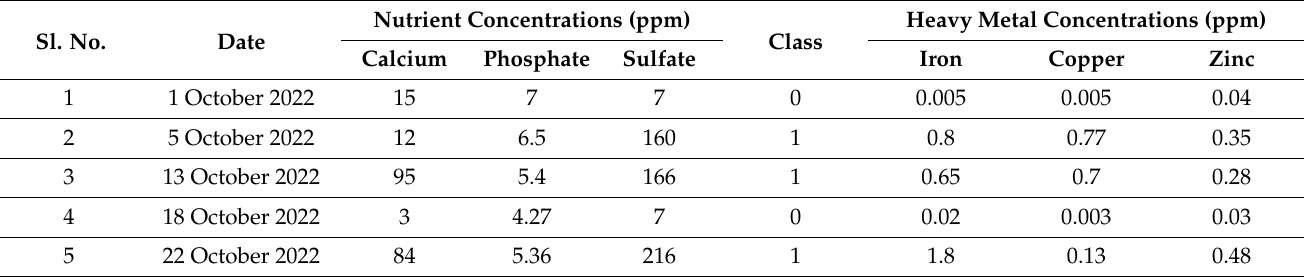
Table 2. Set-Up to monitor heavy metals in a test hydroponic set-up by regulation of nutrients.